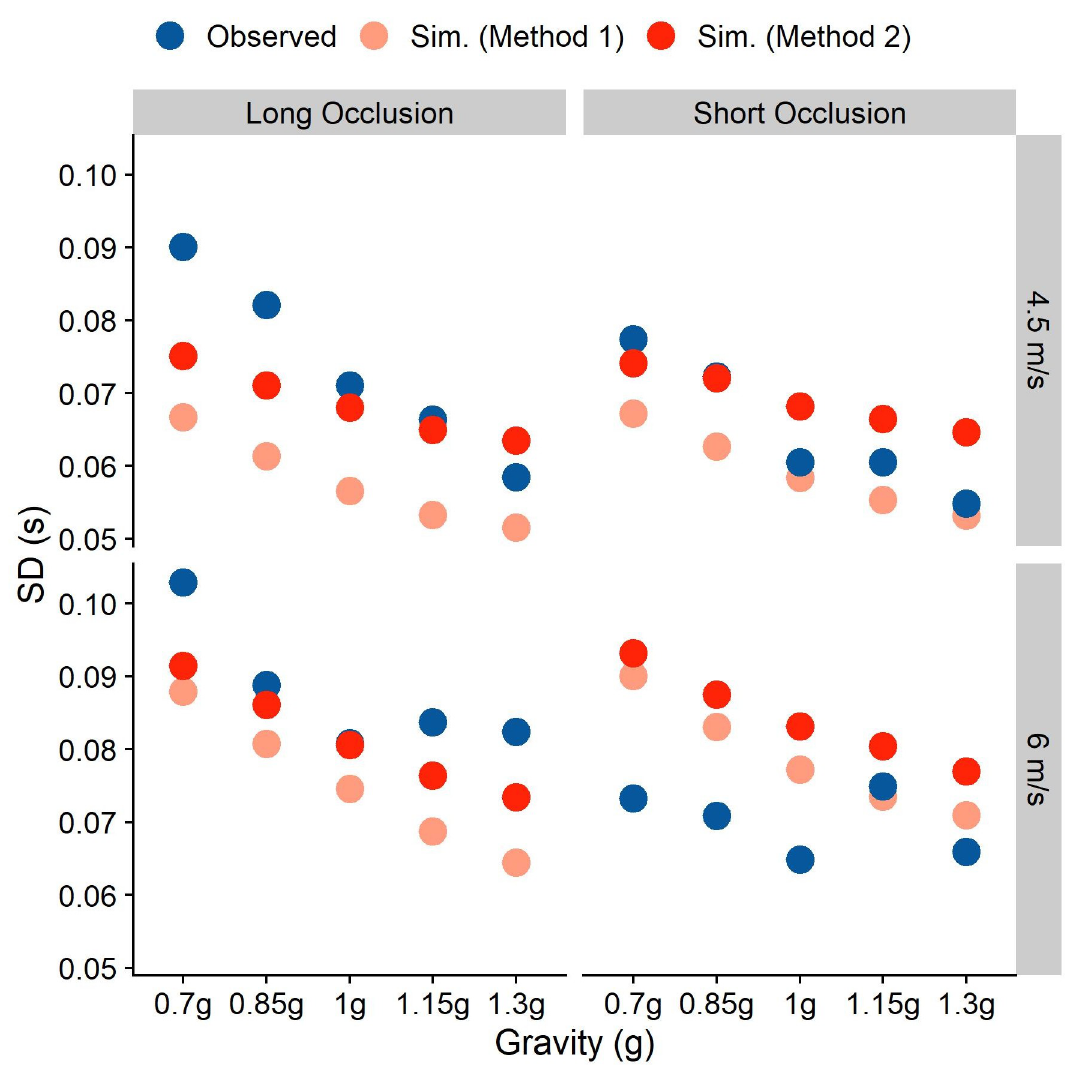
Fig 7. Observed and simulated standard deviations separated by occlusion condition, initial vertical velocity and presented gravity. Blue indicates the observed standard deviations across subjects, while the standard deviations simulated through the two-step process (Method 1) are coded light red and the standard deviations simulated through the two-parameter fit (Method 2) are coded solid